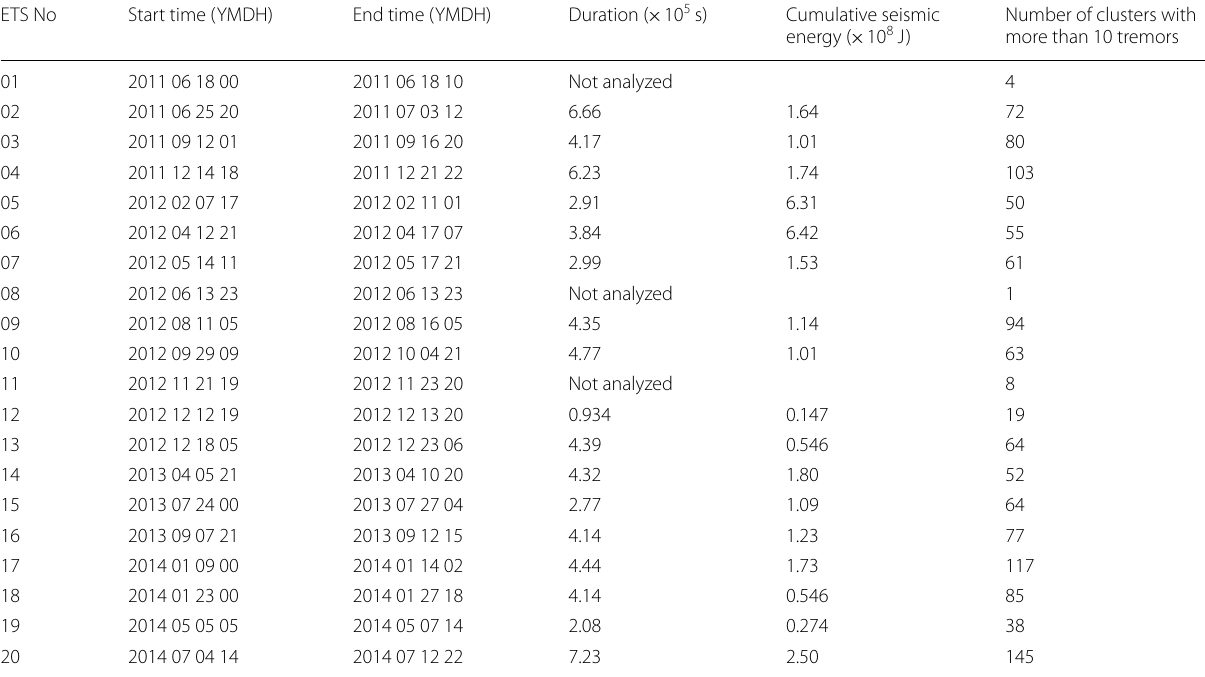
Table 2 Duration and cumulative seismic energy release of ETS events, estimated from hypocenter clusters with more than 10 tremors ETS